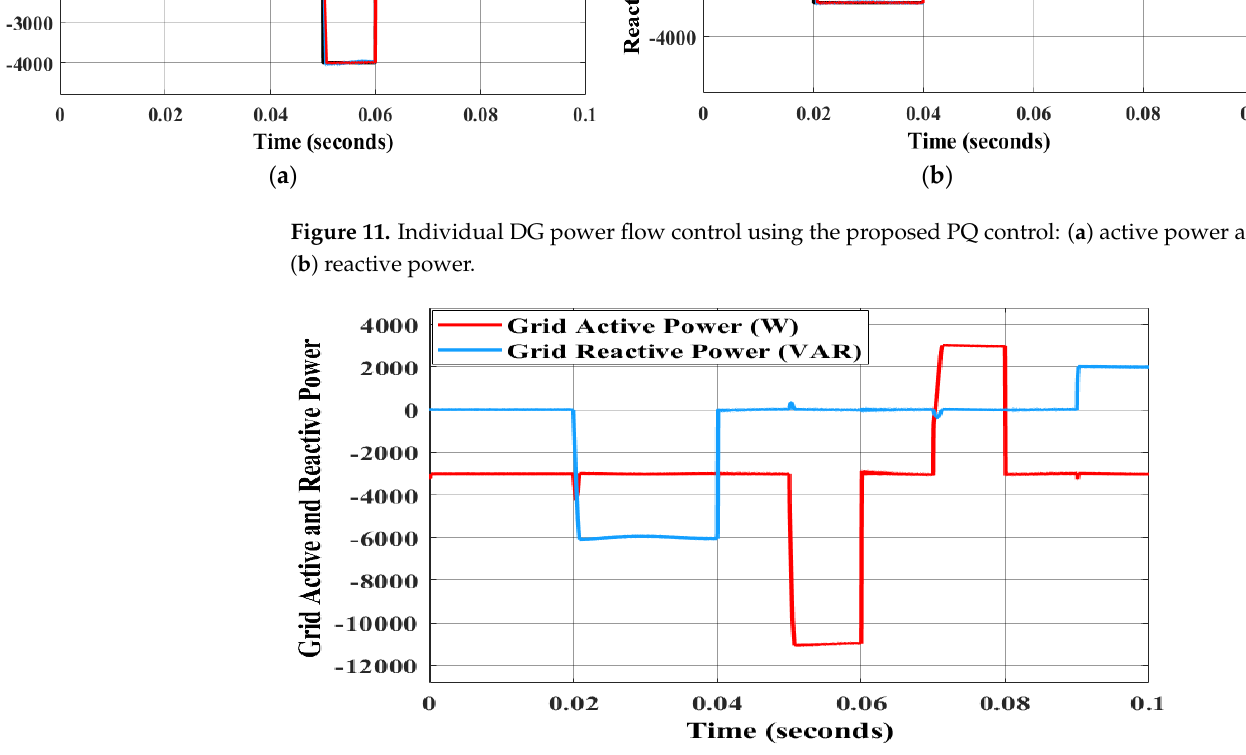
Figure 12. Active and reactive net power flows to the grid using PQ-control-based digital PR controllers.